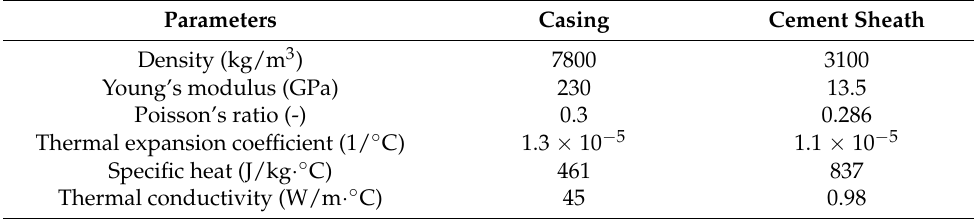
Table 1. Material properties of the casing and cement sheath.